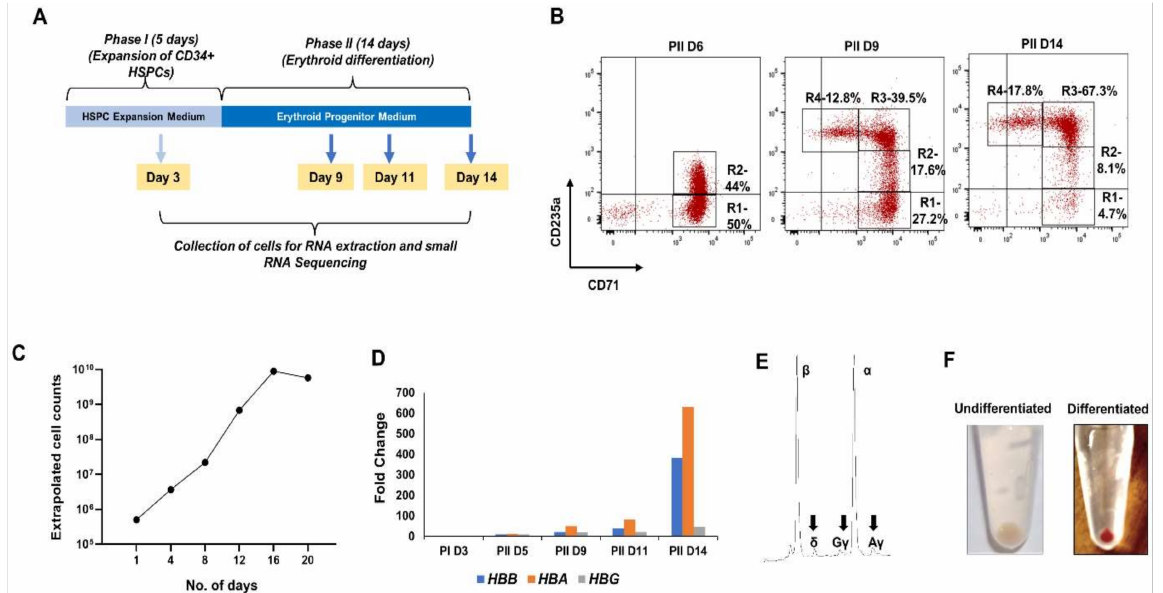
Figure 1. Ex-vivo erythropoiesis to generate cells at different stages of erythroid differentiation. ( A ) Schematic representation of ex-vivo erythropoiesis protocol used in this study. In Phase I of the culture, CD34+ HSPCs were expanded in HSPC expansion medium for 5 days. Subsequently, the cells were cultured in the erythroid progenitor medium for 14 days for progressive erythroid differentiation. Cells were collected from Day 3 and Day 5 of Phase I and Day 9, Day 11, and Day 14 of Phase II of the culture for small RNA expression analysis. ( B ) Flow cytometry analysis of the expression of erythroid surface markers, CD71 and CD235a. ( C ) Extrapolated cell counts showing cell proliferation during ex-vivo erythropoiesis. and ( D ) fold change in the expression of α , β , and γ globin mRNAs on different days of ex-vivo erythropoiesis. ( E ) HPLC analysis of α , β , δ , and γ globin chains in the erythroid cells from the late stage of differentiation. ( F ) The color of pellets of undifferentiated cells from Phase I and terminally differentiated erythroid cells from the end of Phase II of the